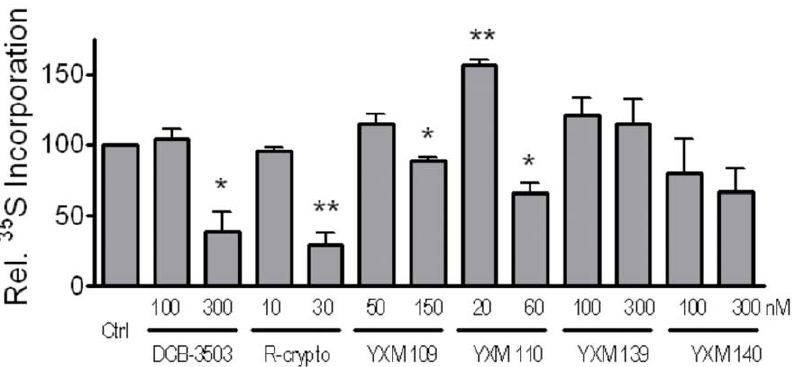
Figure 4. Effect of cryptopleurine analogs treatment for 4 hours on protein synthesis profile assessed by [ 35 S]-methionine/cysteine incorporation in HepG2 cells. The incorporation of [ 35 S]-methionine/cysteine was measure by scintillation counter, and presented as percentage to untreated control cells. (**, p , 0.01; *, p , 0.05).